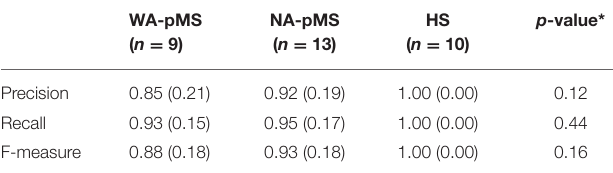
TABLE 4 | Performance (precision, recall, and F-measure) scores for the intra-individual template-based detection (IITD) algorithm.